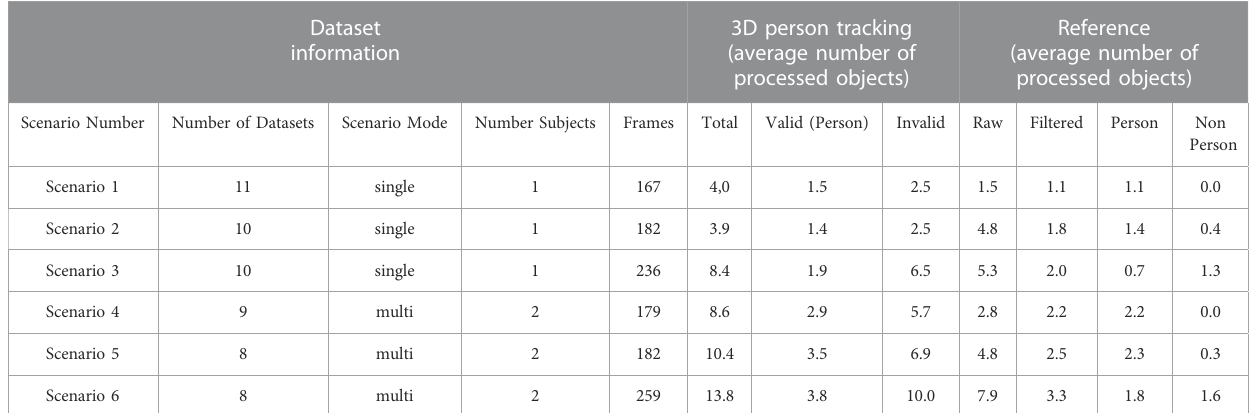
TABLE 2 Final summary of the statistical